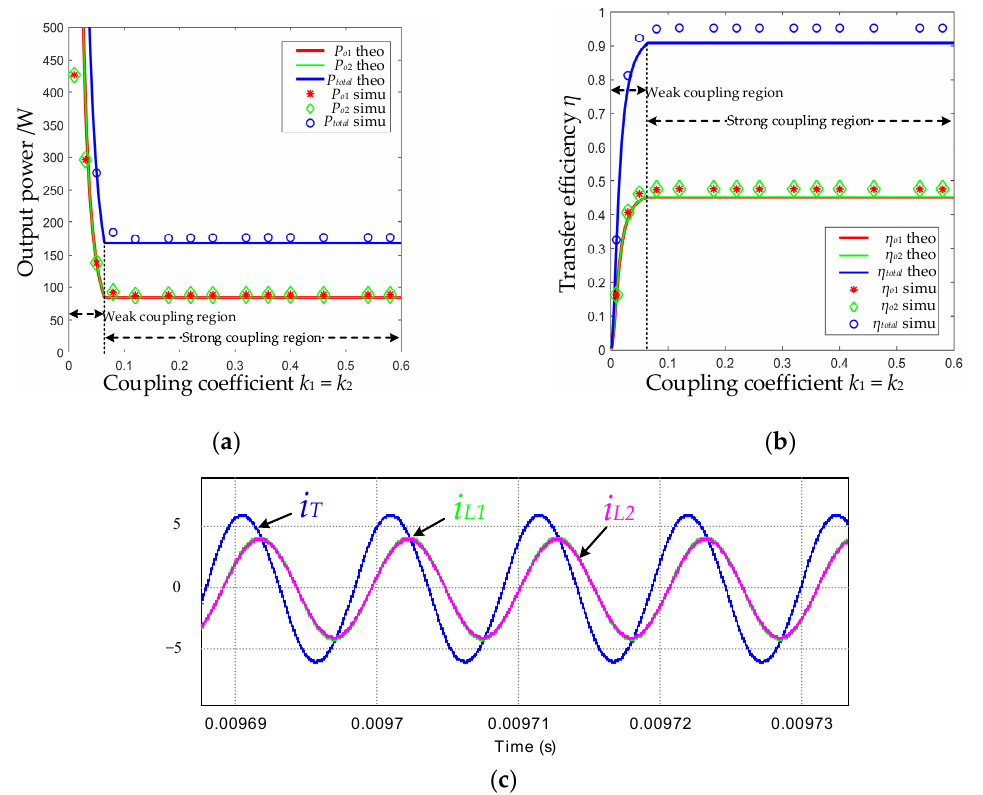
Figure 12. Power distribution and efficiency distribution when k 1 = k 2 : ( a ) power distribution; ( b ) efficiency distribution; ( c ) waveform of input and output current when k 1 = k 2 = 0.15. (In the figure, “simu” is the abbreviation of “simulation”, which represents the simulation results, the same below.)